Question: What visual encoding does this figure use to show its data?
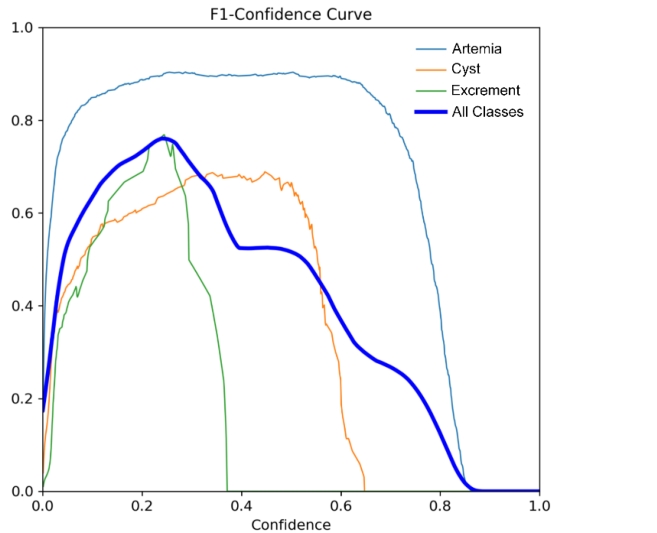
Answer: line